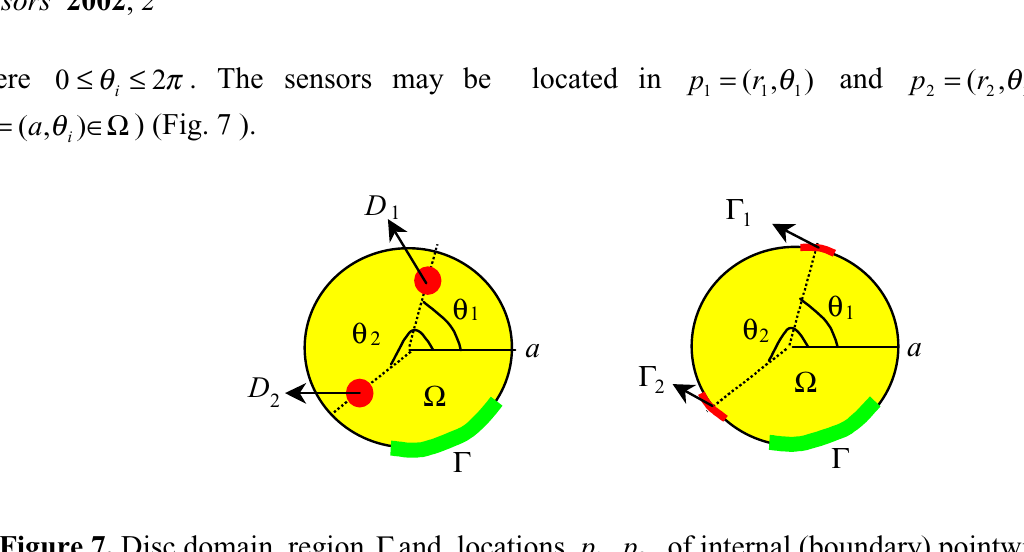
, pp of internal (boundary) pointwise 21